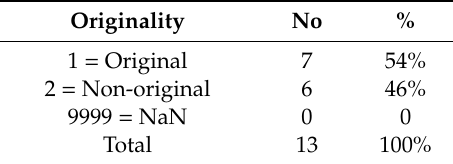
Table A2. Original / Non-original articles.